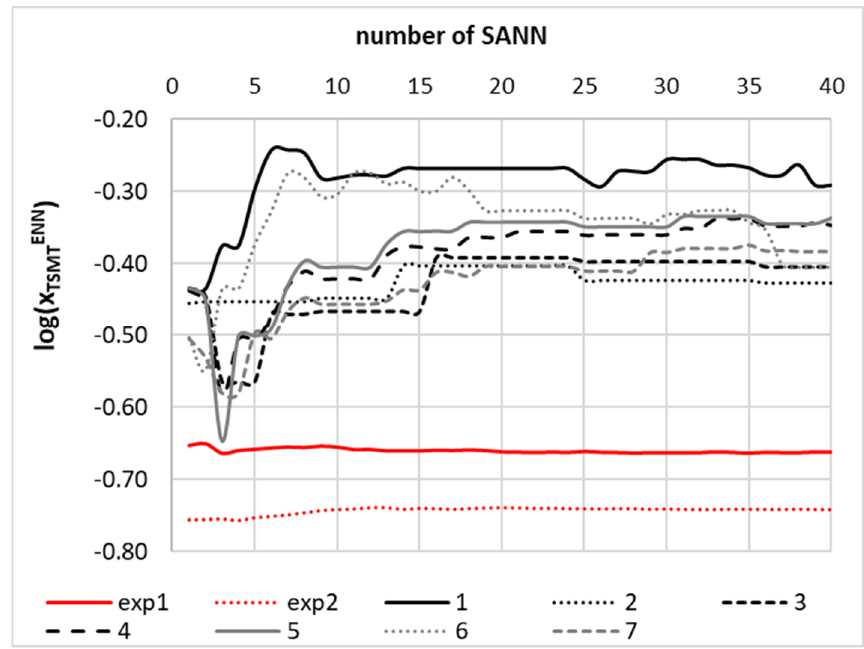
Figure 9. Results of solubility screening with an aid of developed ENN. Individual SANNs are sorted with rising RMSD, and values are averaged systematically, including increasing number of SANNs. The mean value predicted by ENN corresponds to number 40. The following systems are presented: exp1: DMF, exp2: DMSO, 1: 4-formylmorpholine, 2: formamide, 3: N-methylformamide, 4: DMF + formamide ( x 2 * = 0.8), 5: DMF + N-methylformamide ( x 2 * = 0.4), 6: methanol + formamide ( x 2 *=0.4), 7: methanol + N-methylformamide ( x 2 * = 0.2).